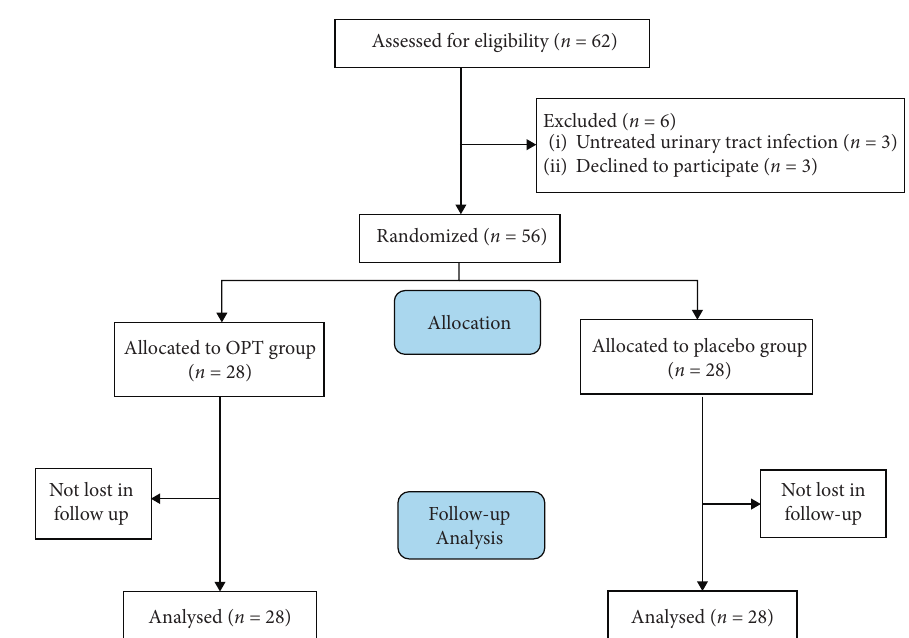
Figure 1: Randomization, treatment, and follow-up procedures.